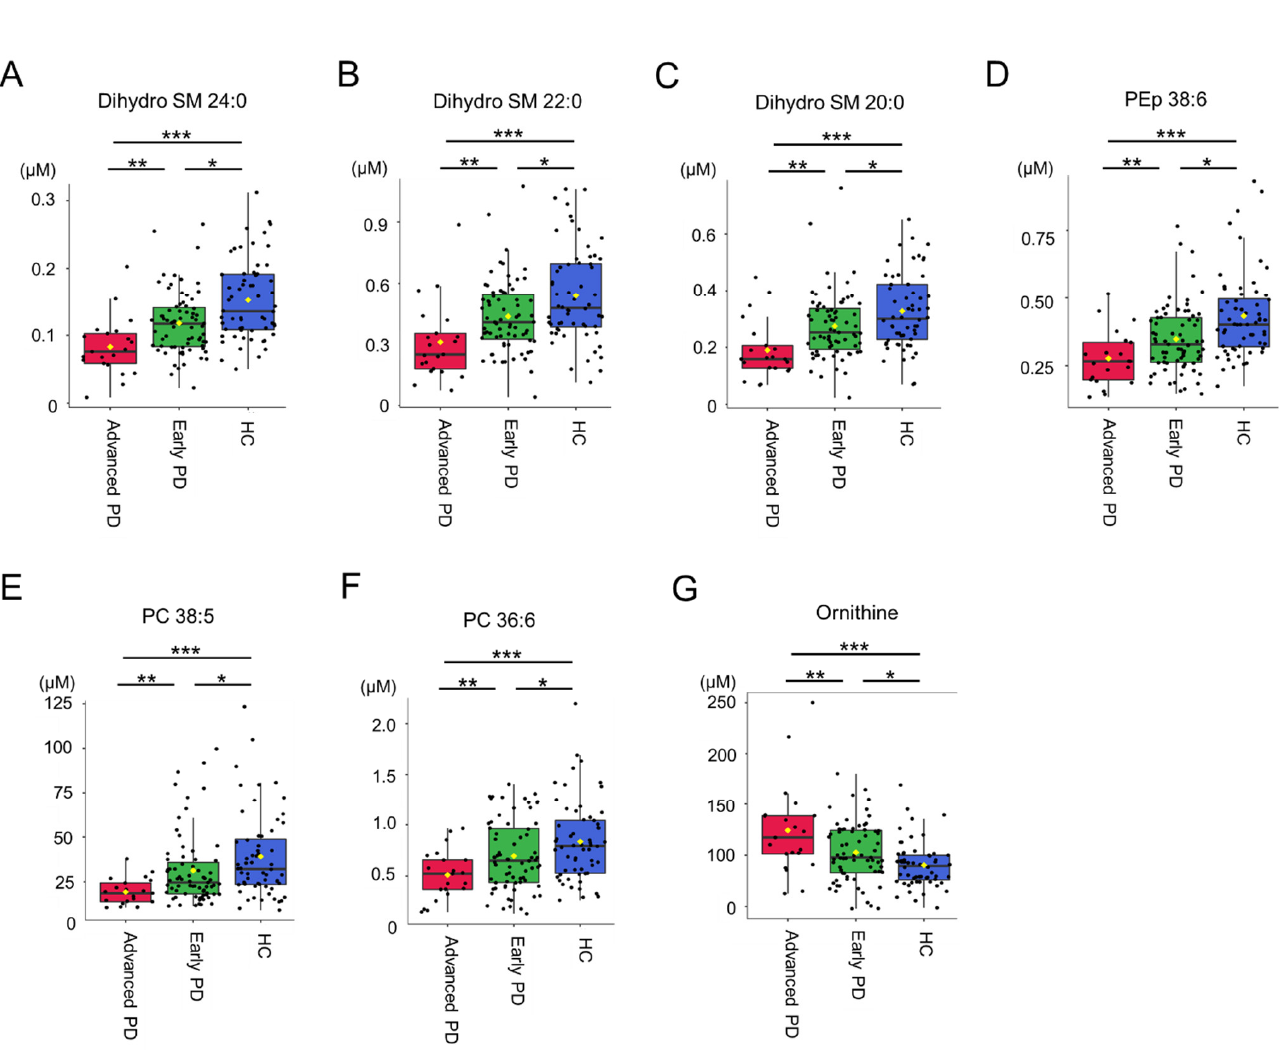
Figure 2. Differences in ( A ) dihydro sphingomyelin (SM) 24:0, ( B ) dihydro SM 22:0, ( C ) dihydro SM 22:0, ( D ) phosphatidylethanolamine-plasmalogen (PEp) 38:6, ( E ) phosphatidylcholine (PC) 38:5, ( F ) PC 36:6, and ( G ) ornithine among Parkinson’s disease (PD) patients at early (early PD) and advanced stages (advanced PD), and the healthy controls (HC). *: Statistically significant between early and advanced PD. p < 0.05, One-way analysis of variance with Bonferroni correction. **: Statisti- cally significant between early PD and HC. p < 0.05, One-way analysis of variance with Bonferroni correction. ***: Statistically significant between advanced PD and HC. p < 0.05. One-way analysis